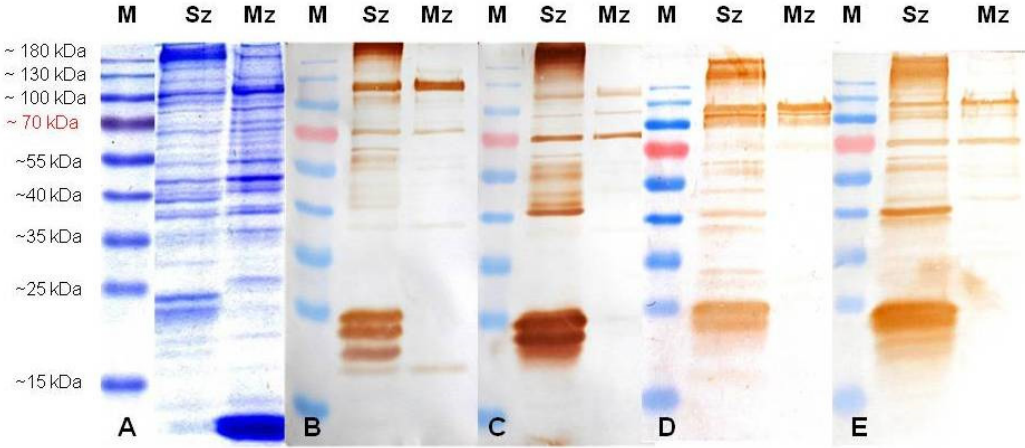
Figure 5. Proteins from the sporozoites (Sz) and merozoites (Mz) of the wild-type E. tenella strain resolved by 12% SDS-PAGE and stained with Coomassie Brilliant Blue ( A ) or probed in immunoblots with antisera from two rabbits (diluted at1:8000) ( B , C ), and two SPF birds (diluted at 1:2000) ( D , E ) at 49 days after four immunizations with 5.3 × 10 6 whole sporozoites of E. tenella . M: molecular weight ladder in kDa.